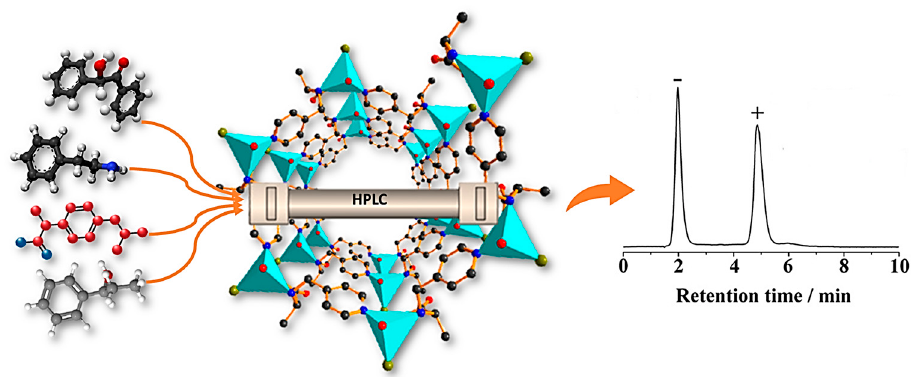
Figure 12. Enantioselective separation of four types of racemic compounds by HPLC through using 3D-molecular sieve-like homochiral CMOF. Injected mass: 20 µ g of each racemate. UV detector, hexane/isopropanol as the mobile phase. Reprinted (adapted) with permission from [119]. Copyright 2014 American Chemical Society and redrawn with PowerPoint 365 software.